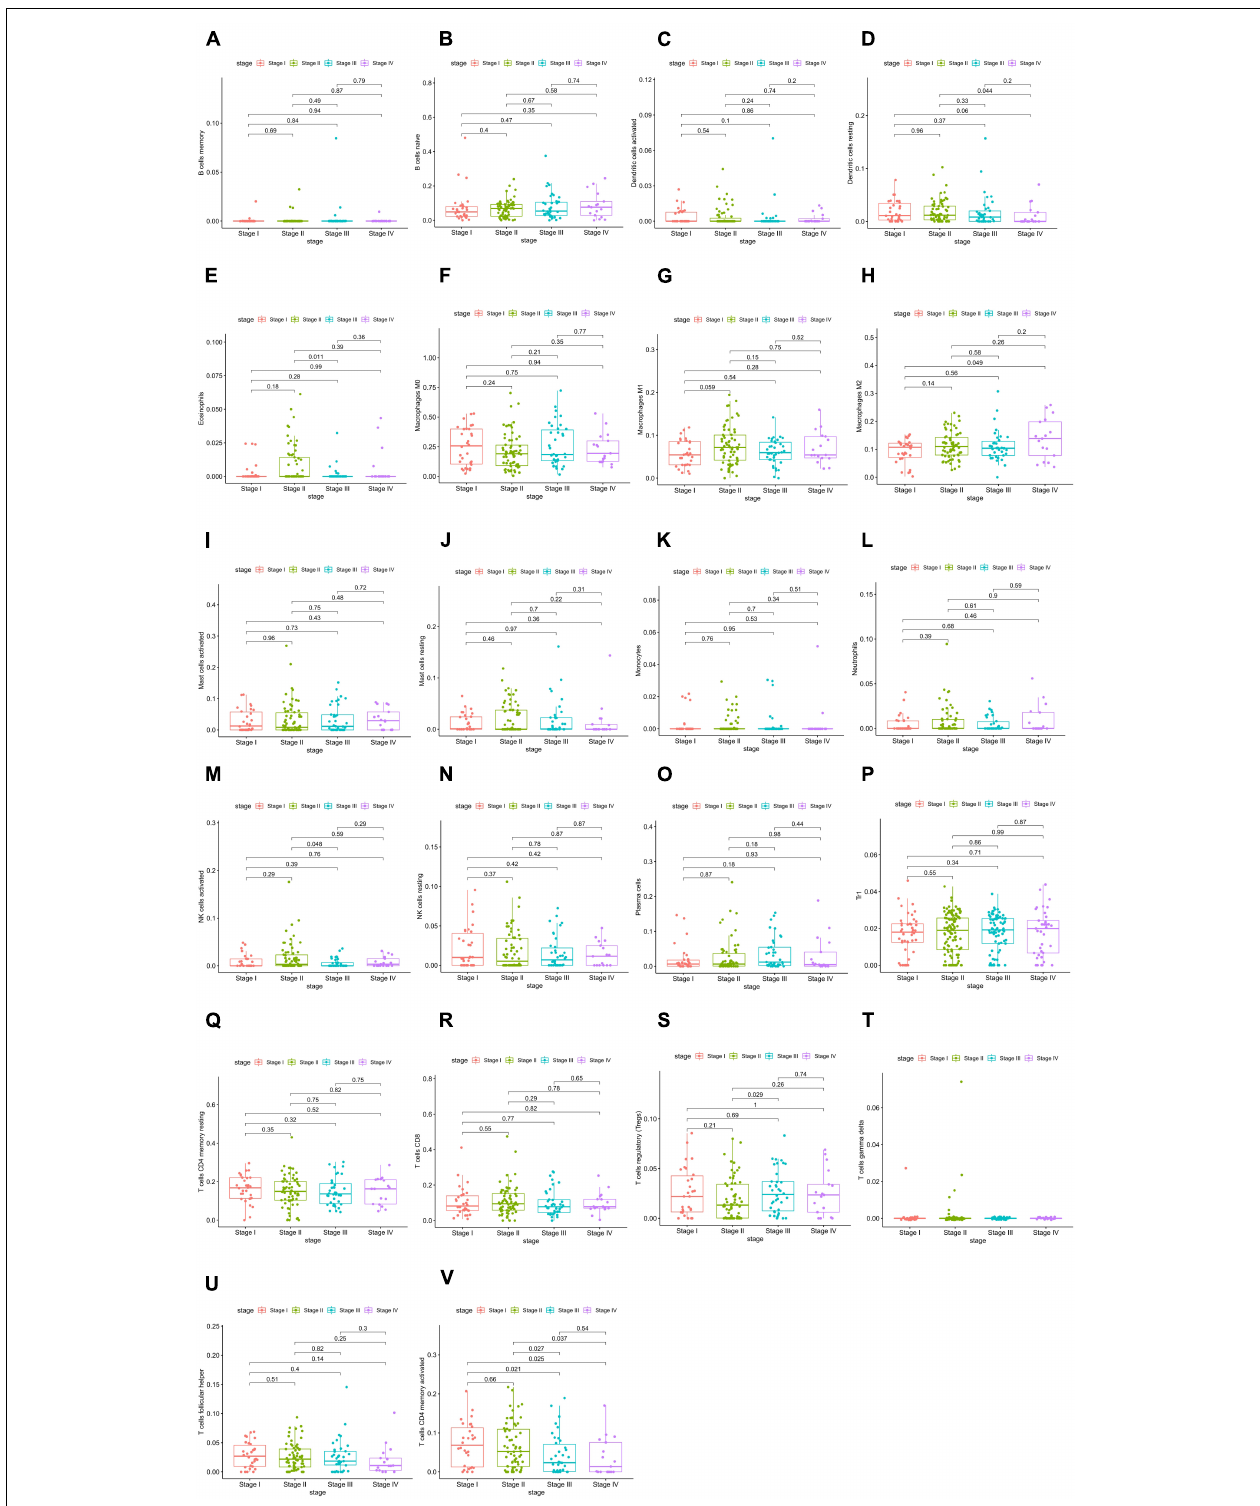
FIGURE 5 | (A–V) Relative expression of the 22 immune cells in the T1–T4 stages of patients.